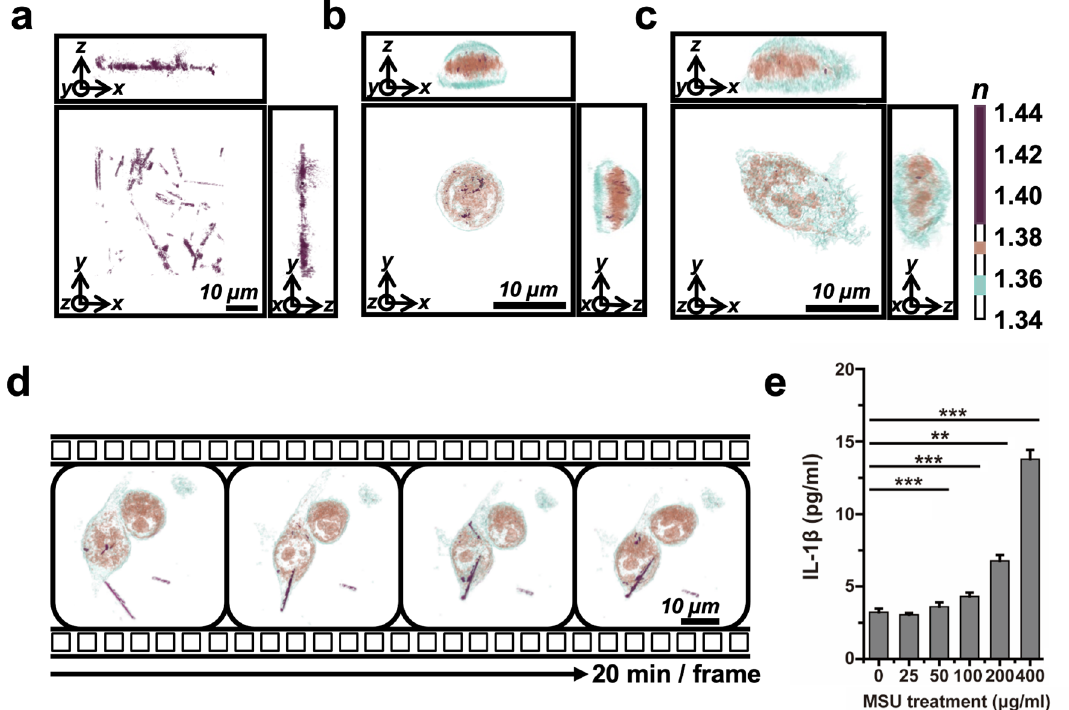
Figure 2. Three-dimensional (3D) optical diffraction tomography (ODT) of monosodium urate (MSU) crystals. ( a ) Synthetic MSU crystals were recorded as RI ≥ 1.385. See also Supplementary Movie S1. ( b ) A monocytic THP-1 cell. ( c ) A macrophage derived from a THP-1 cell after treatment with phorbol 12-myristate 13-acetate (PMA) for 72 h. The color bar indicates the 3D rendered refractive index (RI) distribution (n = 1.340–1.440). Each square shows the x–y, y–z, or x–z plane. n: refractive index. ( d ) Time-lapse monitoring of macrophage THP-1 cells after treatment with 10 µg/mL monosodium urate (MSU) crystals for 2 h. The MSU crystals, with RI ≥ 1.385, are indicated in purple. See also Supplementary Movie S2. ( e ) IL-1β production of THP1 cells assessed via ELISA at 3 h after treatment with MSU crystals. ** P < 0.01, *** P < 0.001, ns: not